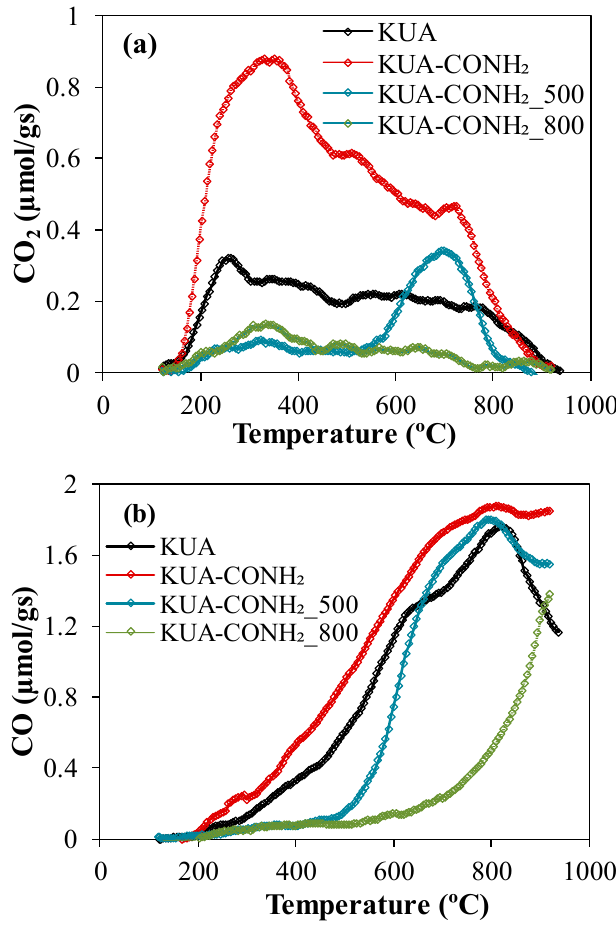
Figure 3. Comparison between ( a ) CO 2 and ( b ) CO TPD profiles of KUA, KUA-CONH 2 , KUA-CONH 2 _500 and KUA-CONH 2 _800.